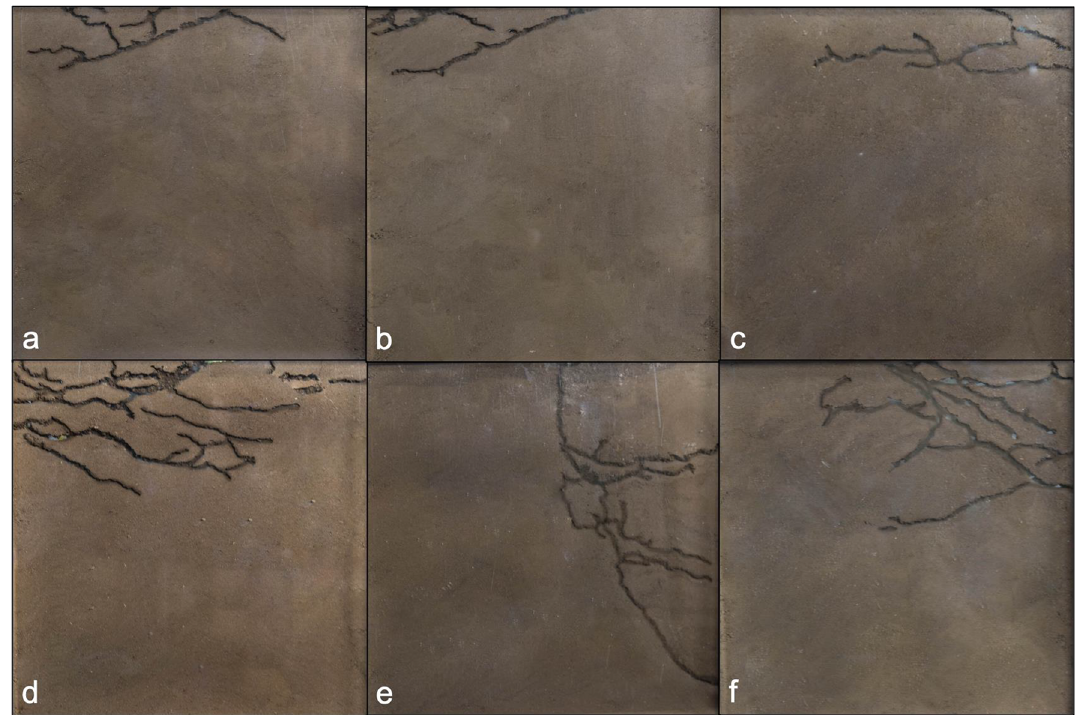
Figure 2. Examples of nests after the 7-day excavation period. ( a – c ) are nests from colonies that experienced the low-temperature treatment, whereas ( d – f ) are nests from colonies that experienced the high-temperature treatment.